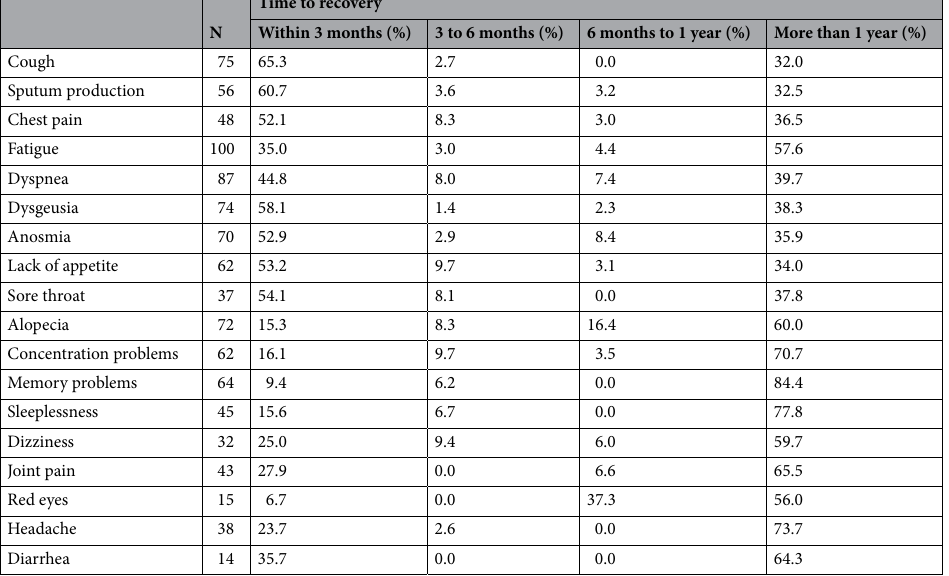
Time to recovery N Within 3 months (%) 3 to 6 months (%) 6 months to 1 year (%) More than 1 year